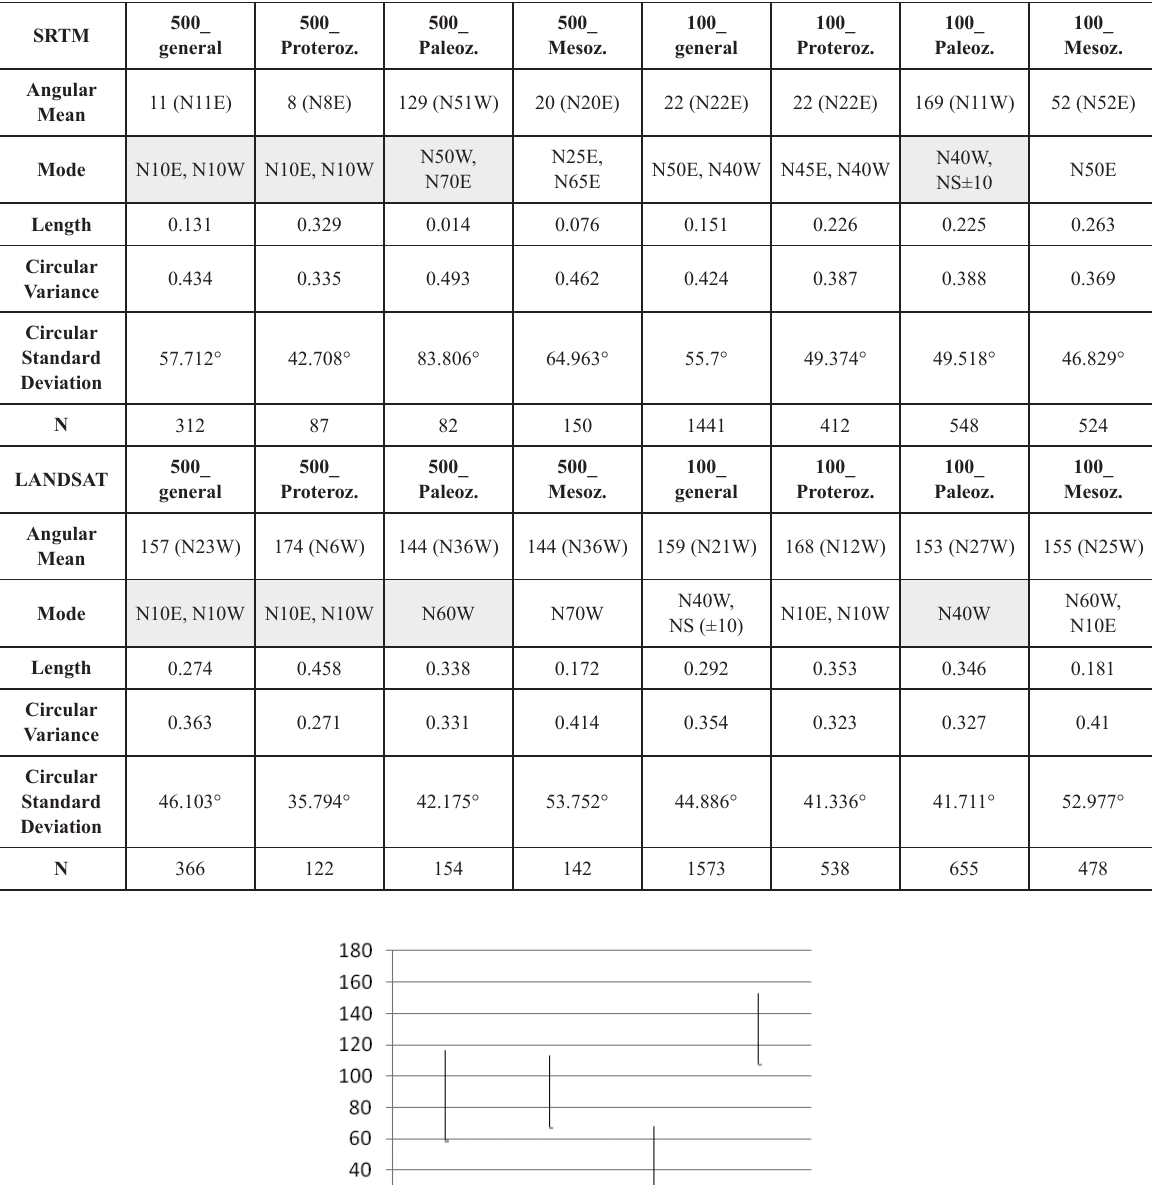
Synthesis of the descriptive statistics after lineament extraction from LANDSAT and SRTM images at 1:500,000 and 1:100.000 scales. Patterns classified in general, Proterozoic, Paleozoic and Mesozoic domains. Highlighted cells refer to similar values.